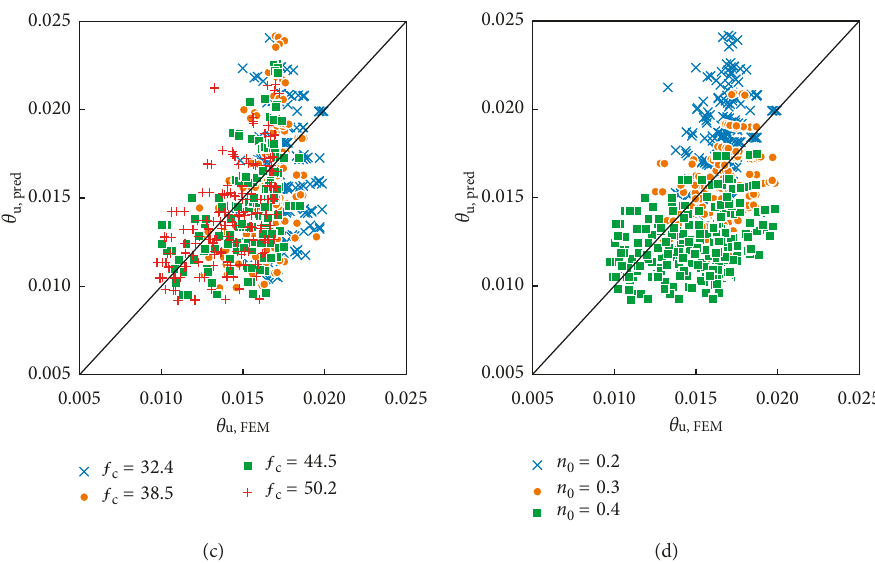
Figure 13: Distribution of numerical and predicted ultimate rotation. (a) Different shear span ratios. (b) Different steel plate ratios. (c) Different concrete grades. (d) Different axial load ratios.